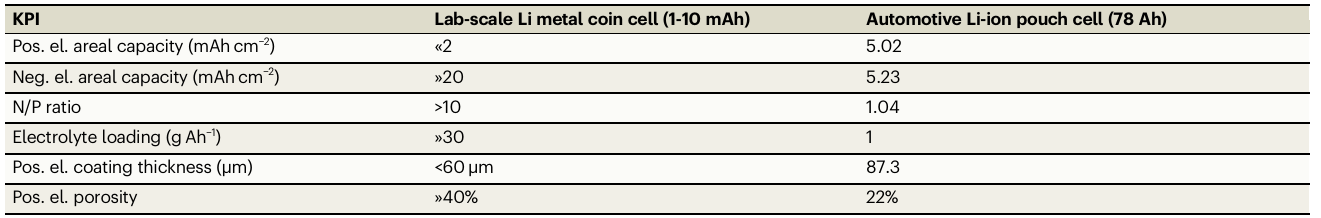
Table 1 | Comparison of a few KPIs for a 2032 lab scale Li metal coin cell (1-10 mAh) with a commercial lithium-ion cell used in a Volkswagen ID.3 electric car 195